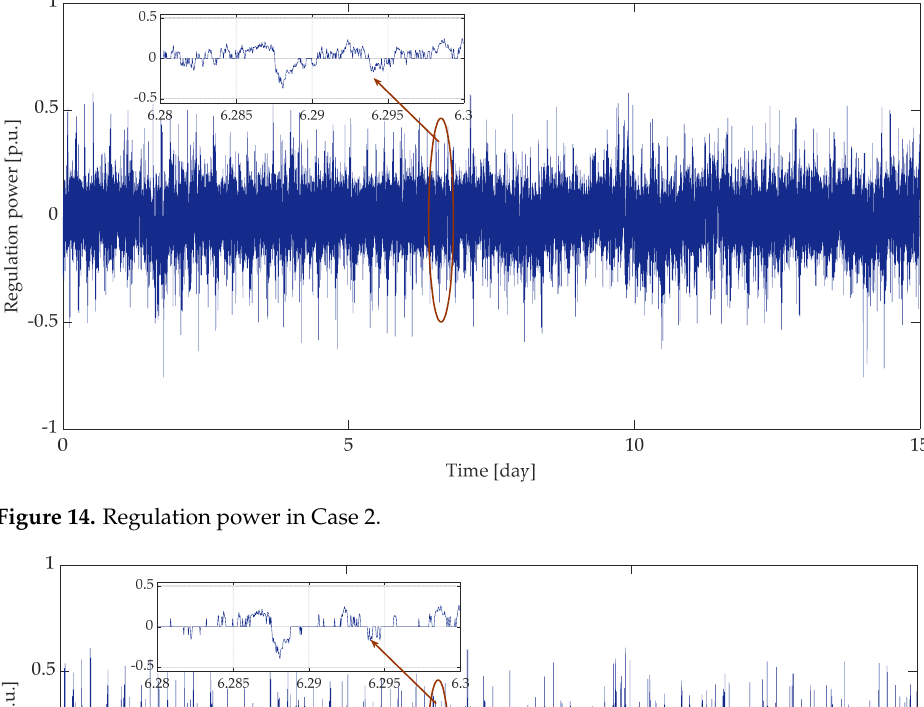
Figure 14. Regulation power in Case 2.